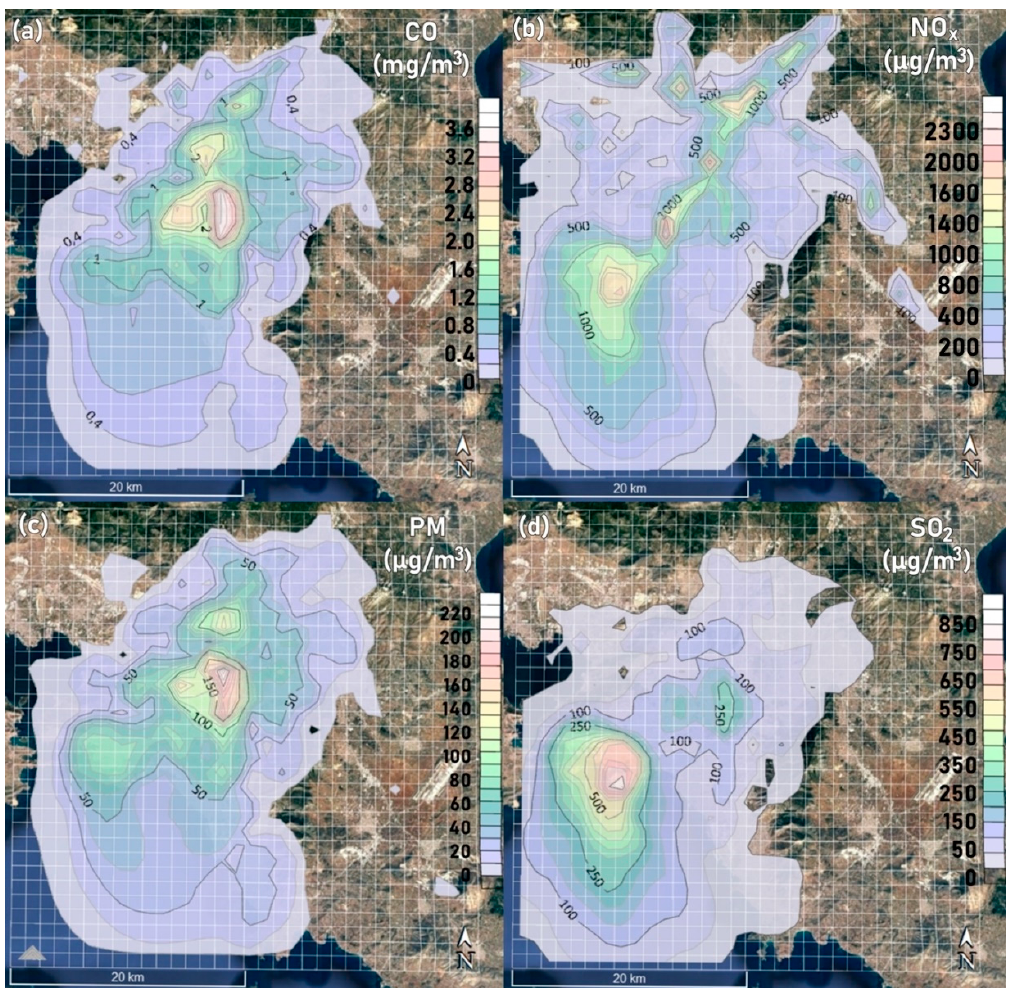
Figure 8. Contours of maximum local concentrations calculated in the present study and overlaid on Google Earth imagery (Map data: Landsat / Copernicus, SIO, NOAA, U.S. Navy, NGA, GEBCO) for the 1 week simulation period, from all source categories ( a ) CO 8 h average (mg / m 3 ), ( b ) NO x 1 h average ( µ g / m 3 ), ( c ) PM10 24 h average ( µ g / m 3 ), and ( d ) SO 2 1 h average ( µ g / m 3 ).